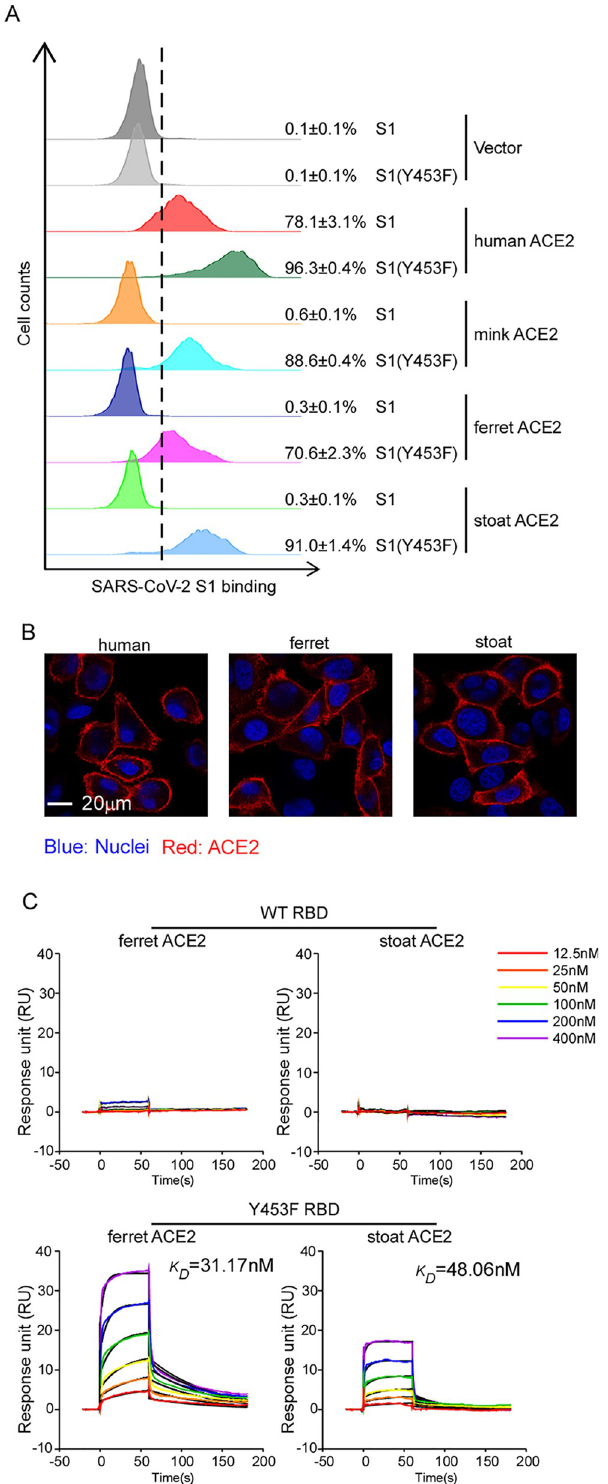
Fig 4. Increased binding of Y453F RBD protein to Mustelidae ACE2 orthologs. (A) HeLa cells were transduced with human or Mustelidae ACE2 orthologs as indicated. Transduced cells were incubated with WT or Y453F S1 domain of SARS-CoV-2 C-terminally fused with His tag and then stained with anti-His-PE for flow cytometry